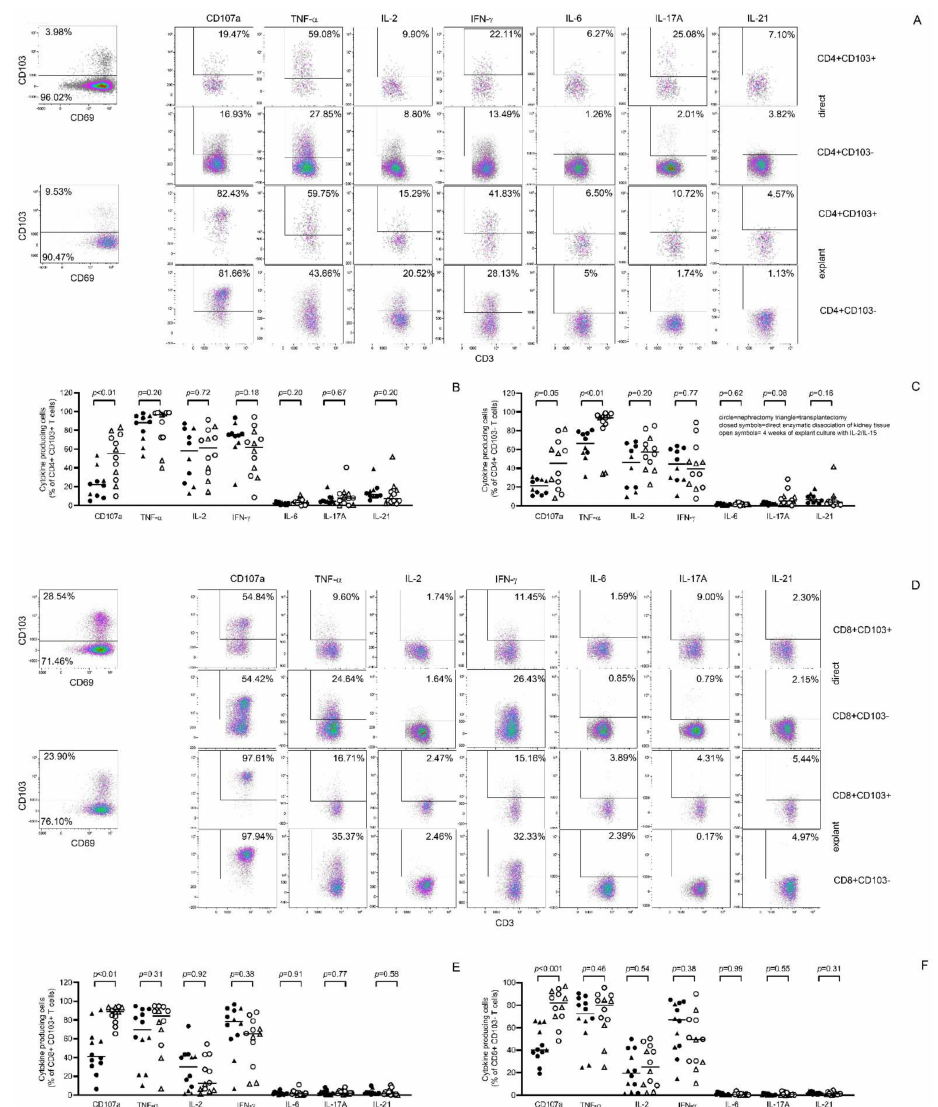
Figure 4. Pro-inflammatory profile was maintained following 4 weeks of explant culture in the presence of exogenous IL-2 and IL-15. Proportions of pro-inflammatory cytokine producing and CD107a- expressing cells were determined upon overnight stimulation of T cells with PMA and ionomycin. In ( A ) (CD4+) and ( D ) (CD8+), a typical flow cytometric example of the gating strategy is depicted. In the upper panel, T cells obtained direct following enzymatic dissociation are depicted (CD103+ in first row, CD103 − in second row), whereas in the lower panel that of T cells harvested following 4 weeks culture kidney tissue is given. Percentages of cytokine producing cells are